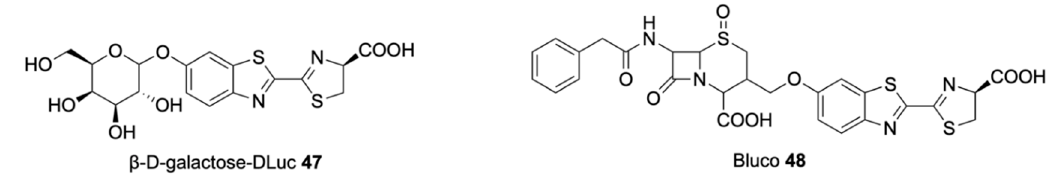
Figure 9. Structures of probes 47 and 48 .